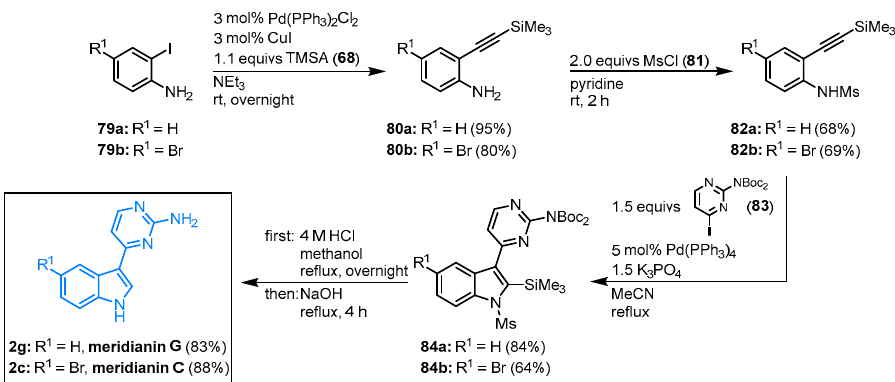
Figure 20. Synthesis of meridianins C and G via palladium-catalyzed domino reaction by Morris [67].